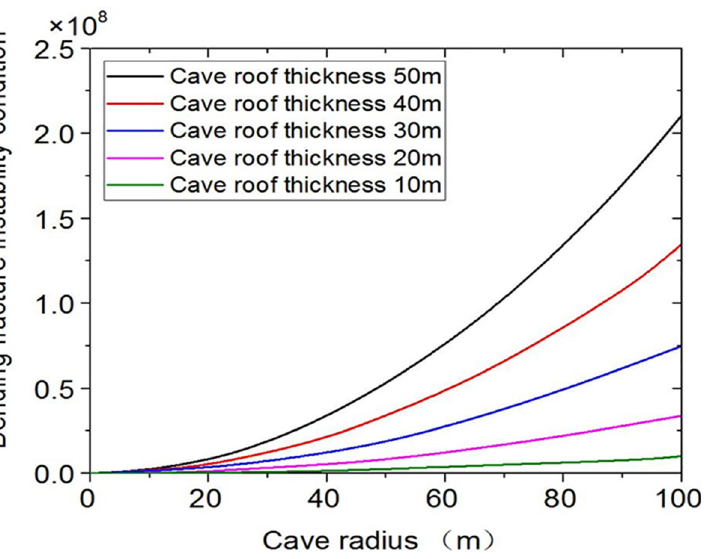
Fig 8. Influence curves of different cave roof